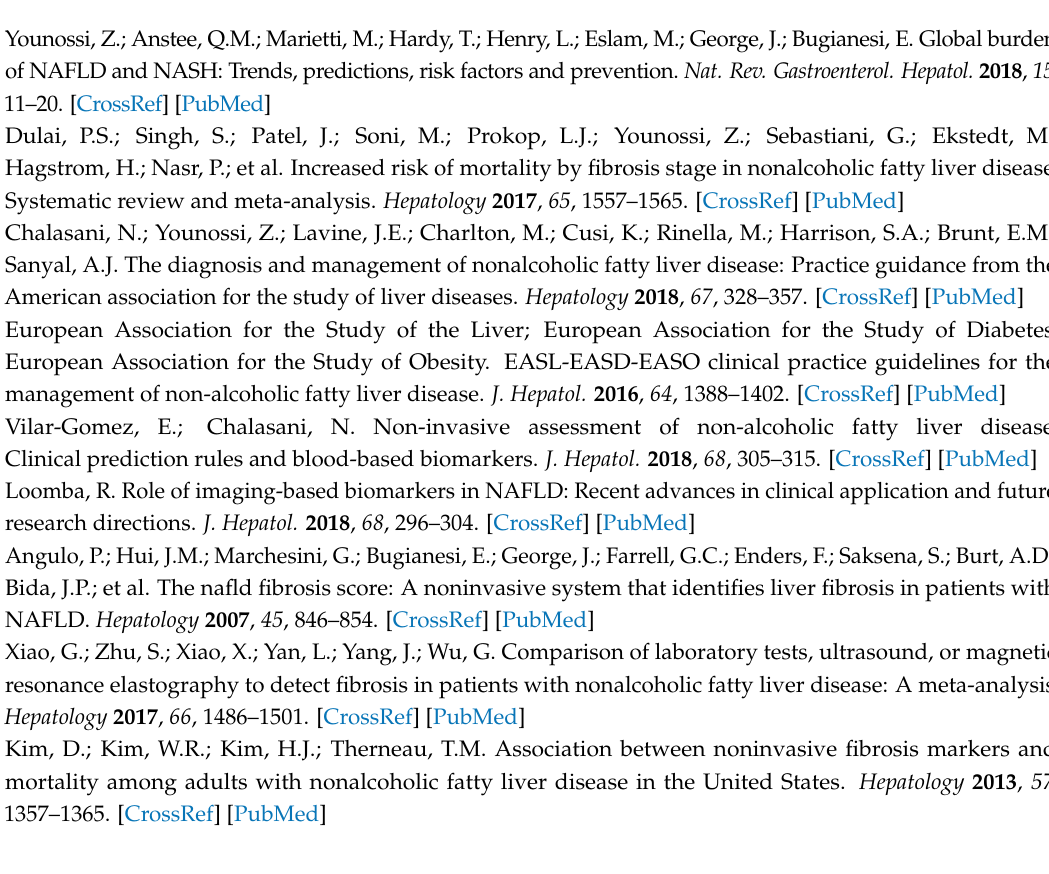
Table S1: Total number of participants and number of cases (deaths) for each study included in the meta-analysis evaluating the risk of mortality according to NAFLD fibrosis score, APRI and FIB-4 values, Table S2: Dose-response meta-analysis using splines with knots at quartiles (0.25, 0.50, 0.75 quartiles) assessing the risk of mortality according to NAFLD fibrosis score, APRI and FIB-4 values, Figure S1: PRISMA (Preferred Reporting Items for Systematic Reviews and Meta-Analyses) checklist, Figure S2: Funnel plots for mortality risk in NAFLD patients: (A) for the high versus low (reference) category of NAFLD fibrosis score, (B) for the high versus intermediate/low category of NAFLD fibrosis score, (C) for the high versus low (reference) category of APRI, (D) for the high versus intermediate/low category of APRI, (E) for the high versus low (reference) category of FIB4, (F) for the high versus intermediate/low category of FIB4, Figure S3: Dose-response association between APRI, FIB-4 and mortality risk in NAFLD patients. Solid lines represent risk ratio, dashed lines represent 95% confidence